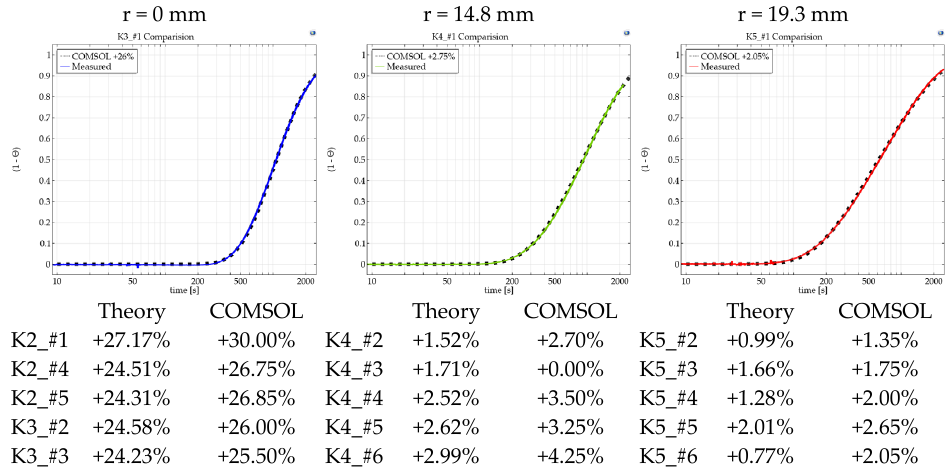
Figure 9. Measurement results of spheres plotted against fitted 2D simulation [12] output for thermal diffusivity, and subsequent measurements below for each position.